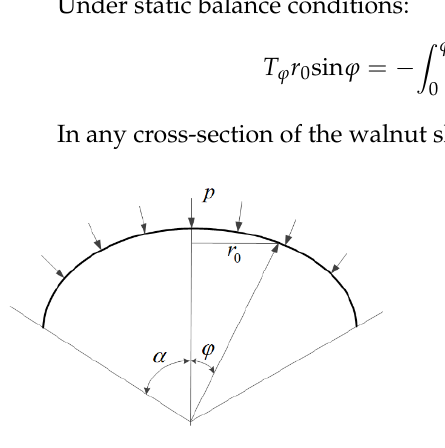
Figure 9. Cross-section diagram of force.